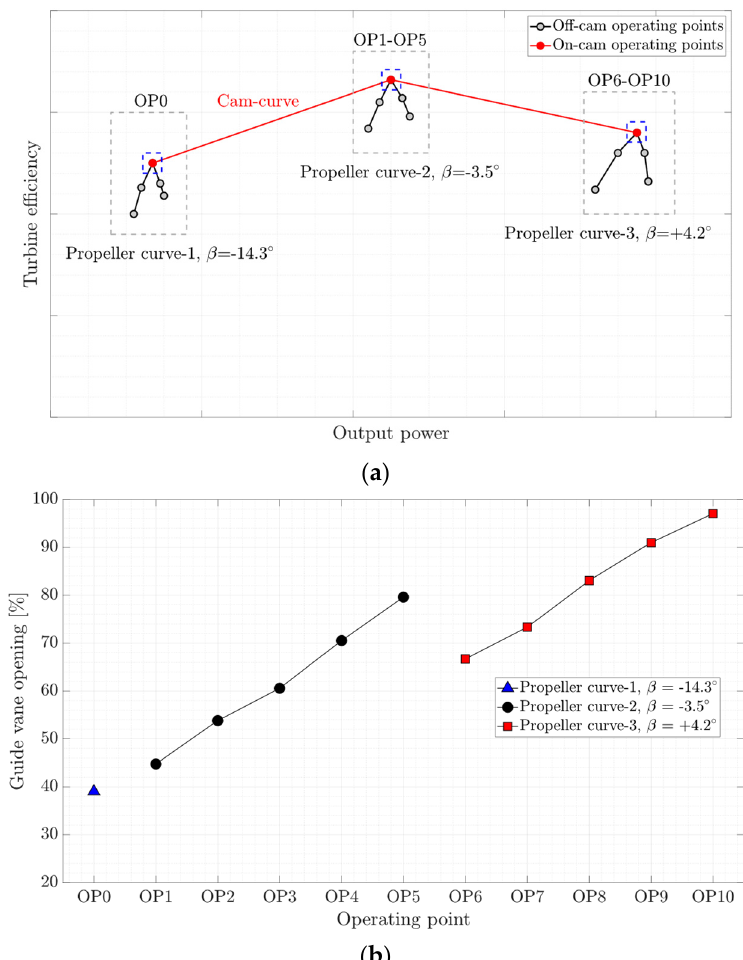
Figure 4. ( a ) Schematic of the investigated operating conditions, ( b ) the guide vane opening and runner blades pitch angle variation for different operating points; ‘OP’ denotes operating point.